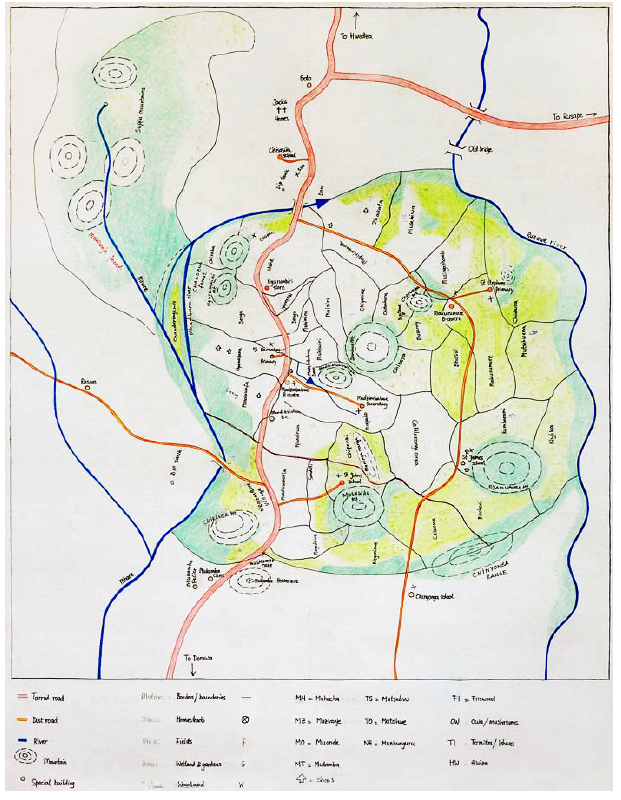
Fig. 2 . Land use map of Ushe ward constructed in a group- mapping exercise. Dark green: woodland; light green: bushland; white/grey: field; orange/red: road; blue: river/ stream; circle: mountain.